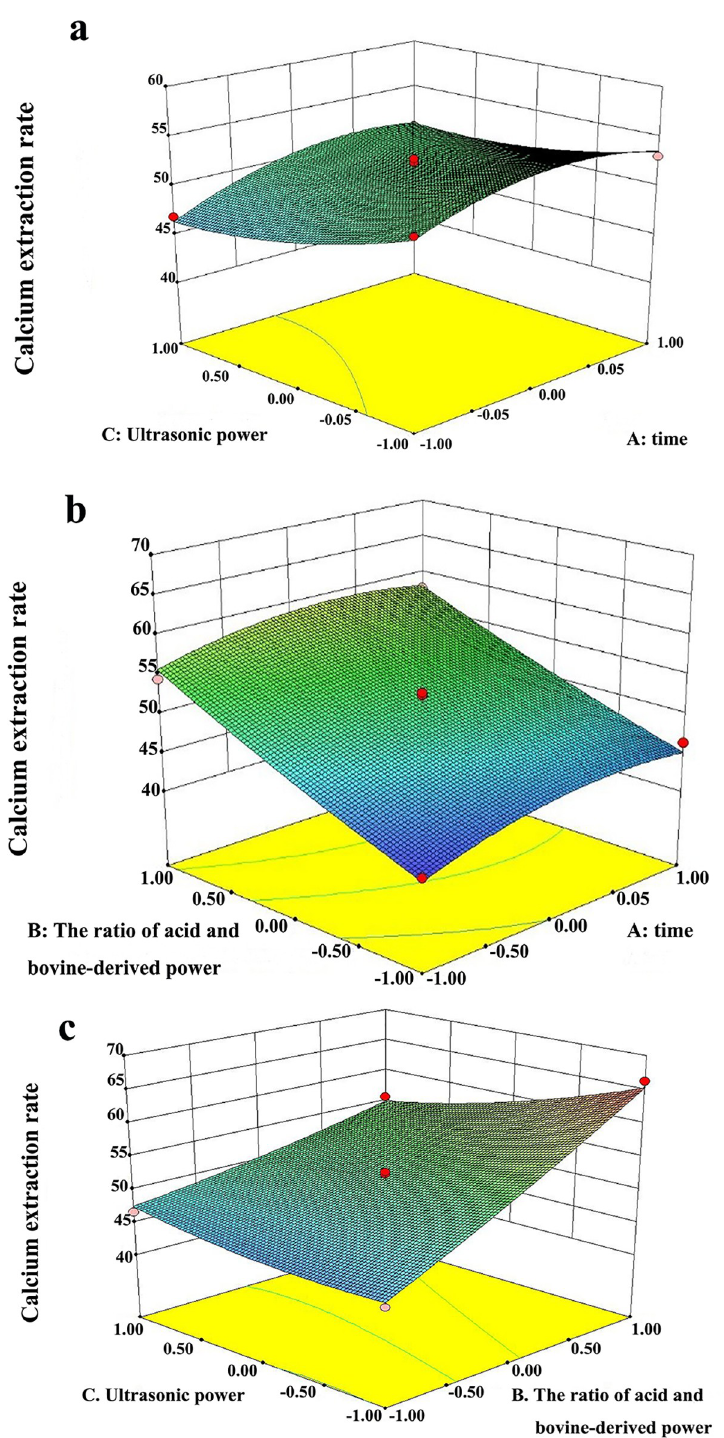
Fig 3. Response surface of calcium extraction rate. (a): The 3-D response surface plot for varying times and ultrasonic powers; (b): The 3-D response surface plot for varying times and the ratio of acid and bovine-derived powder; (c): The 3-D response surface plot for varying ratios of acid and bovine-derived powder and ultrasonic power.